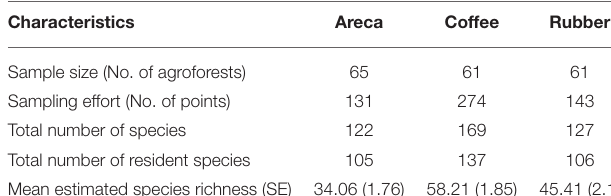
TABLE 1 | Estimated bird species richness across areca, coffee and rubber